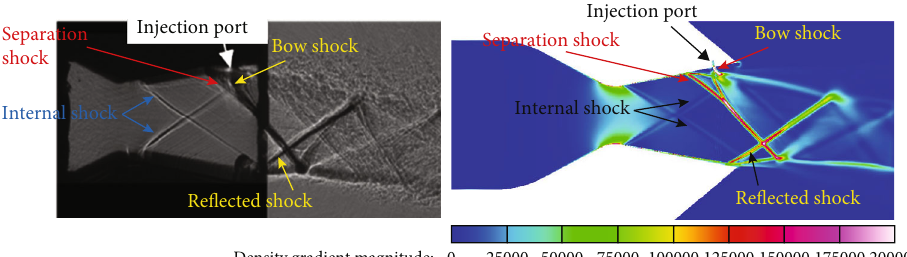
Figure 5: Comparison between experimental schlieren [46] and numerical calculation.